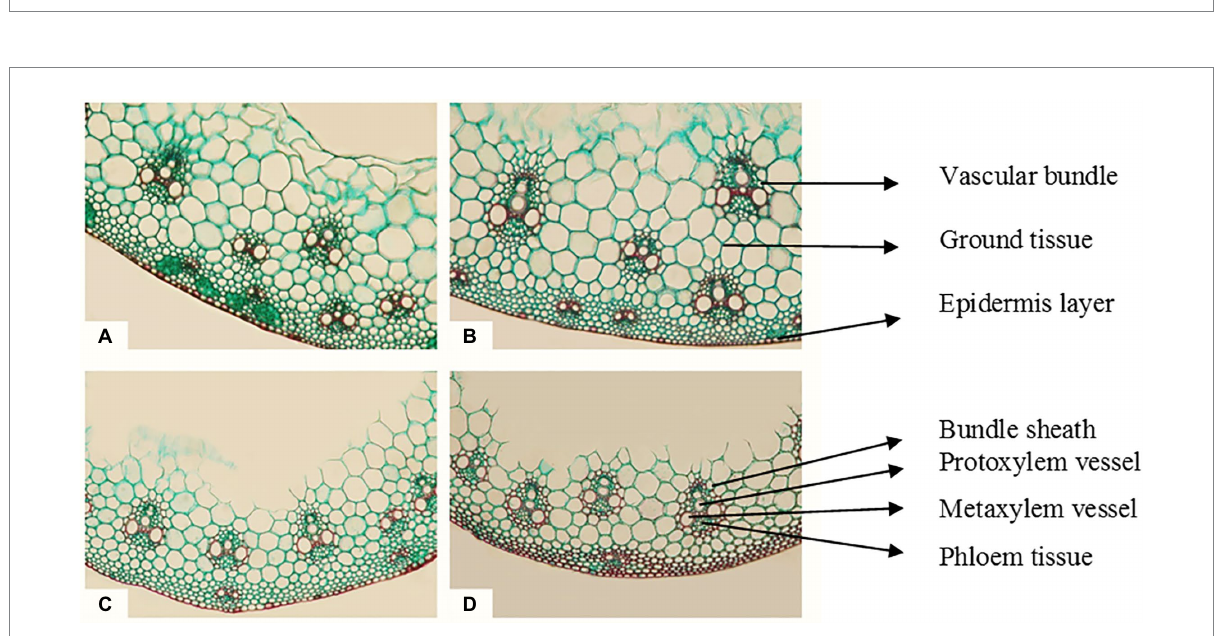
FIGURE 2 Transverse cross sections of the main stem of wheat cv. Sakha 93 at the heading stage (X 300). (A) Control (from plants irrigated with normal tap water); (B) magnetic treatment (from plants irrigated with magnetized water); (C) seawater treatment (from plants irrigated with seawater at 10 dS m − 1 level); (D) magnetic seawater treatment (from plants irrigated with magnetized seawater at 10 dS m − 1